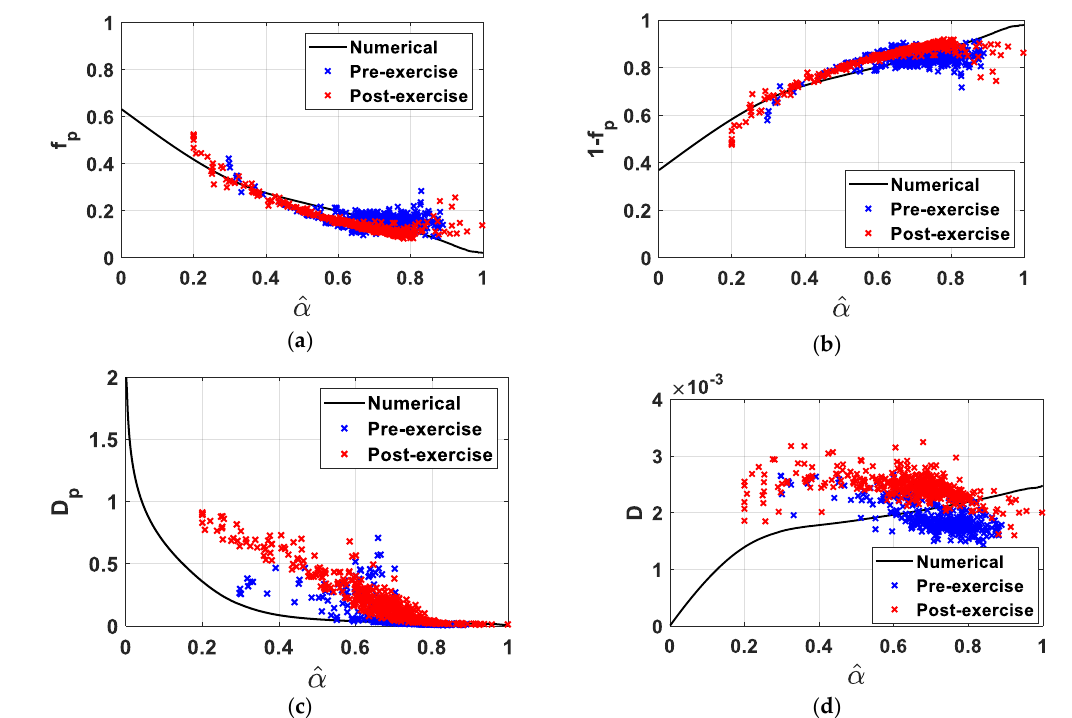
Figure 7. Experimental traces of biexponential model parameters obtained from ROI in the rectus femoris at baseline and post-exercise, superimposed by numerical traces. Both numerical and experimental analysis used: 𝑏 = 0, 3, 7, 10, 15, 20, 25, 30, 40, 50, 70, 100, 200, and 400 s/mm 2 .